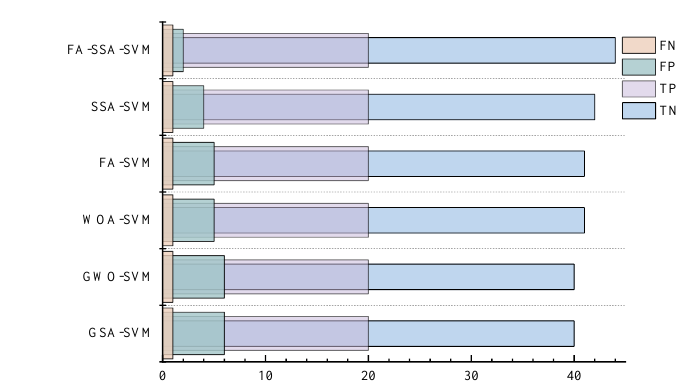
Figure 9. Comparison of confusion matrices. Figure 10 lists the evaluation indices of the different models and their comparison.